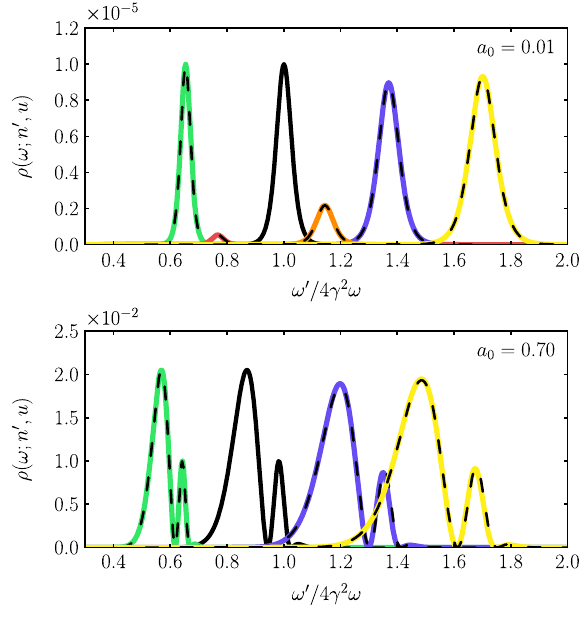
FIG. 1. Photon spectral density (cid:10) ð ! 0 ; n 0 ; u Þ for a single elec- tron by numerical evaluation of Eq. (13) (colored solid curves) and by application of the scaling law (black dashed curves). The upper panel shows the results for low laser intensity, a 0 ¼ 0 : 01 , and the lower panel depicts the nonlinear regime with a 0 ¼ 0 : 7 for a laser pulse length (cid:9) ¼ 18 in both cases. The parameters are: black: ð (cid:2); (cid:6); ’; (cid:3); (cid:4) Þ ¼ ð 80 ; 0 ; 0 ; 0 ; 0 Þ ; green: (65, 0.002, 0, 0.002, 0.03); yellow: (105, 0.005, 0.2, 0.005, 0.5); blue: (95, 0.001, 0.3, 0.003, 0); orange: (130, 0.001, 0.3, 0.01, 0); red: ð 280 ; 0 : 01 ; (cid:11)= 2 ; 0 : 01 ; (cid:11) Þ . The orange and red curves are only shown in the upper panel. The black dashed curves beneath each colored curve are obtained by transforming the black solid curve to the respective new parameters with (23), thus demonstrating the accuracy of the scaling